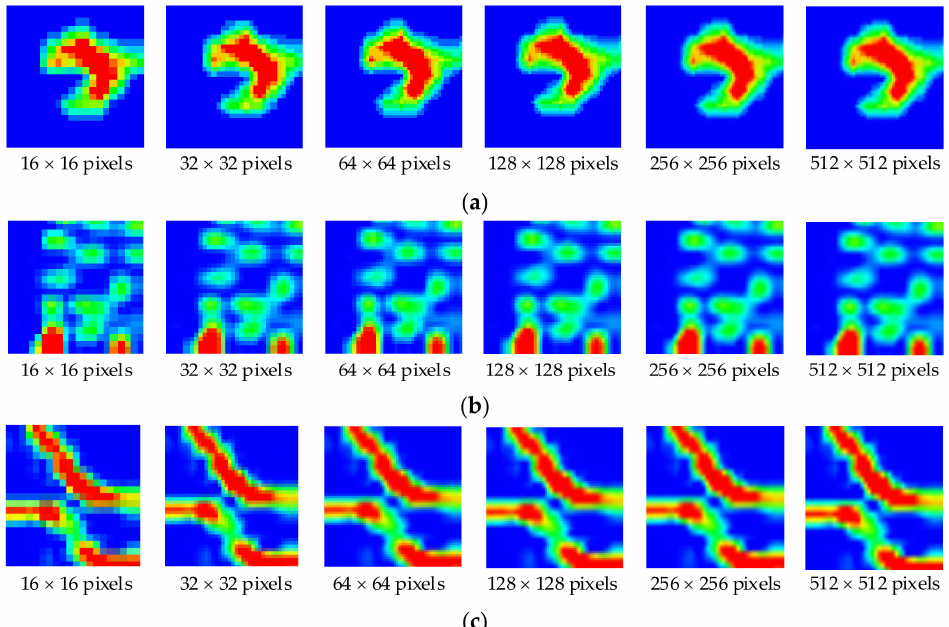
Figure 16. Enhanced tactile images for different objects: ( a ) fixed wrench; ( b ) remote controller; ( c ) plastic tongs.